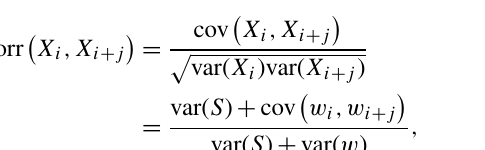
Figure A1. Sketch of a snow trench used for the derivation of the statistical noise model. Vertical isotope profiles X i are spaced at constant intervals of (cid:49)(cid:96) at locations l i = l 0 + i(cid:49)(cid:96) . The horizontal distance d between two profiles X i incremental index i 2 , d = i 2 (cid:49)(cid:96)